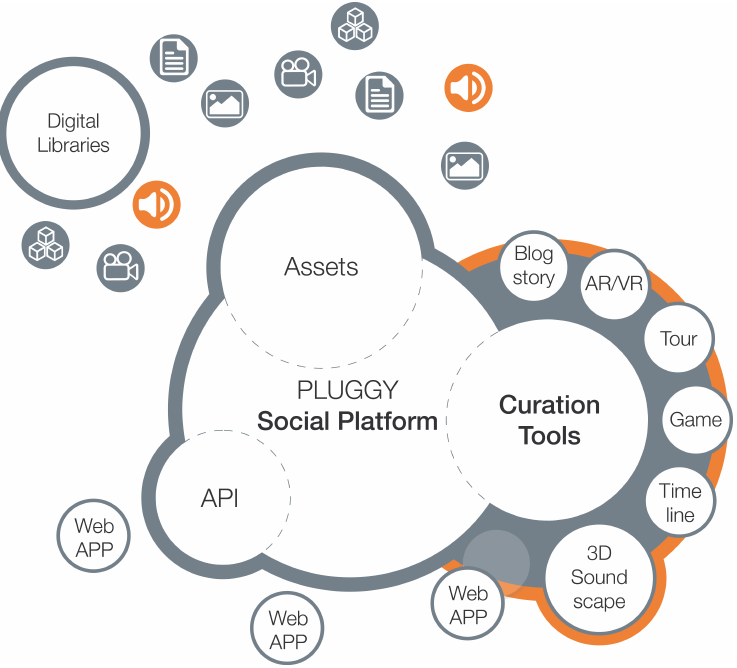
Figure 1. The PLUGGY social platform and apps